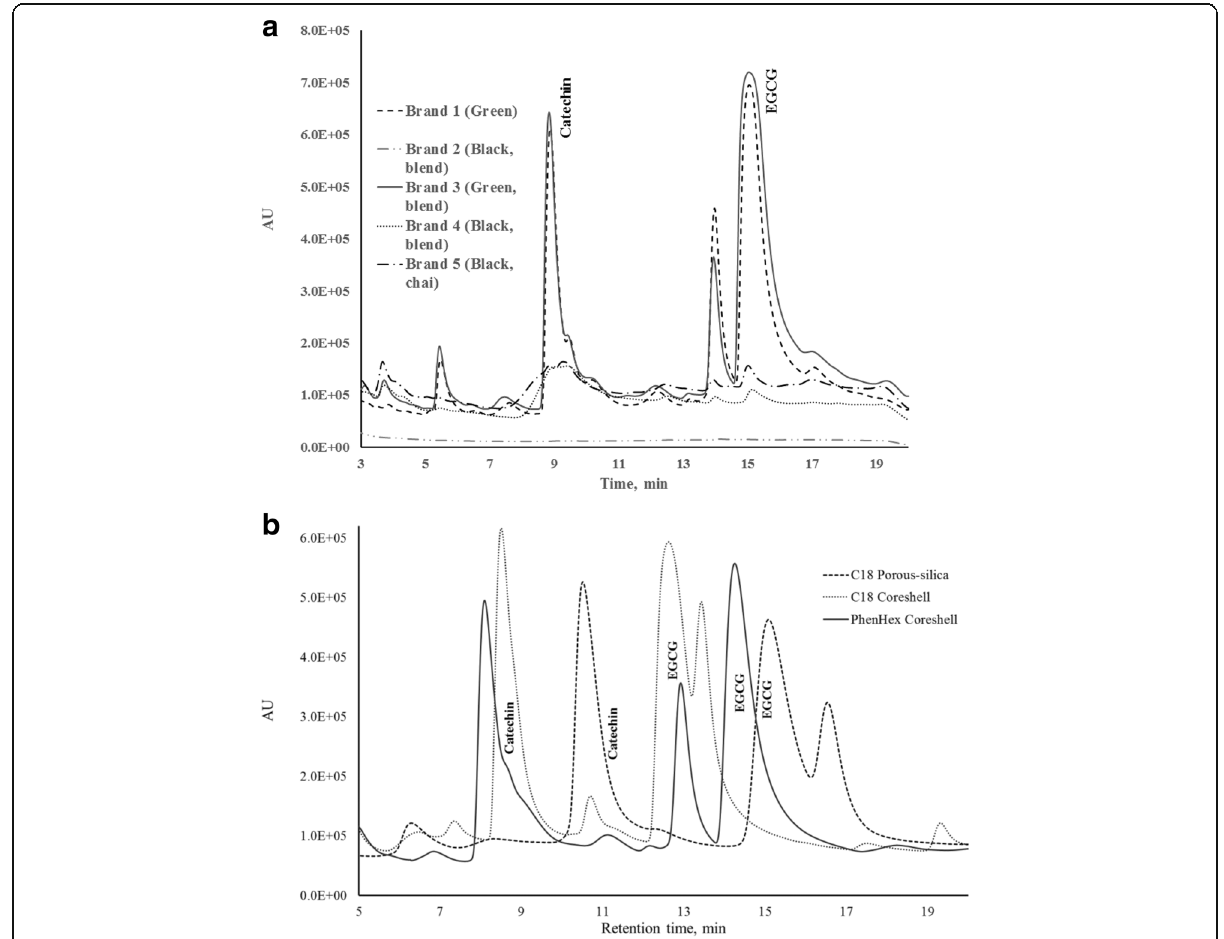
Fig. 4 a HPLC chromatograms of extracts for five tea samples of different type and brand with CUPRAC post-column derivatization using phenyl hexyl core-shell column. b Comparative chromatograms of a tea sample (brand 1 green tea extract) with CUPRAC post-column derivatization re- agent using C18 porous silica, C18 core-shell, and phenyl-hexyl core-shell